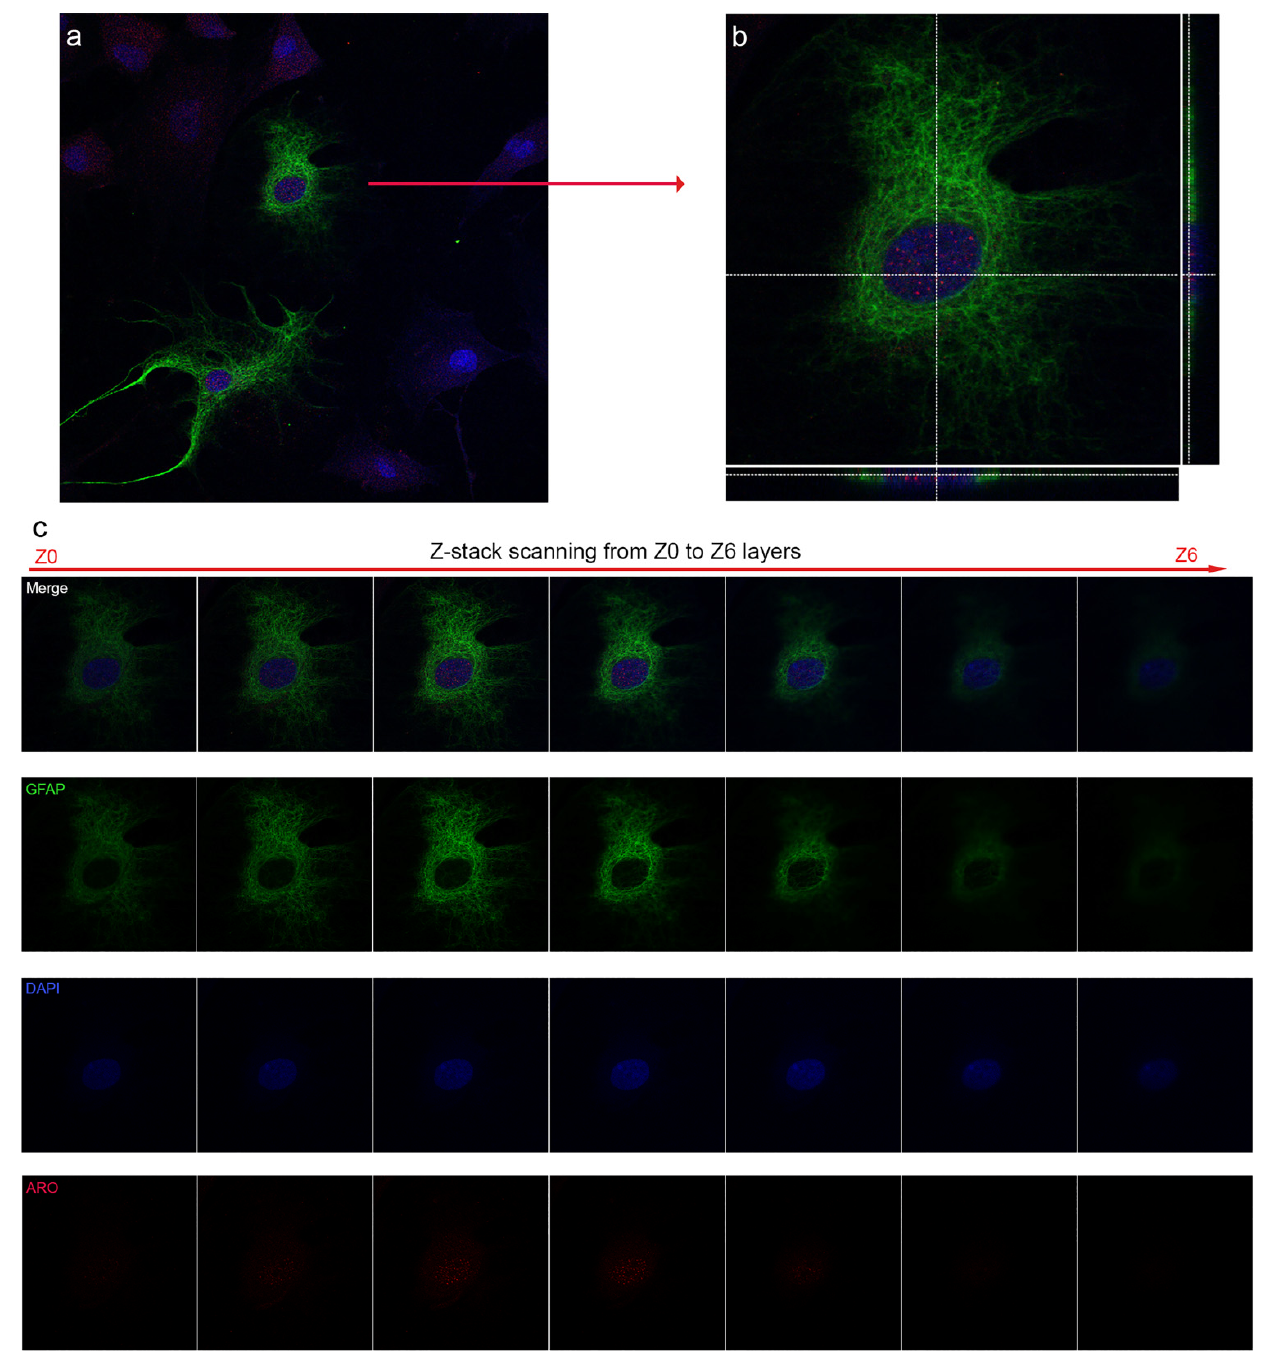
Figure 2. Confocal immunofluorescent analysis of GFAP positive astrocytes. Z-stack scanning analysis confirms Aro (red) immunopositivity in the nuclear layer. One representative cell with GFAP (green) and nuclear Aro immunopositivity ( a ) is selected for Z-stack scanning ( c ). The selected astrocyte shows dotted nuclear Aro positivity ( b ). Orthogonal scales from Z3 layer prove that the Aro signal originates from the nucleus ( b ) as the immunopositive dots colocalize with the nuclear signal (blue). Magnification: 60×.